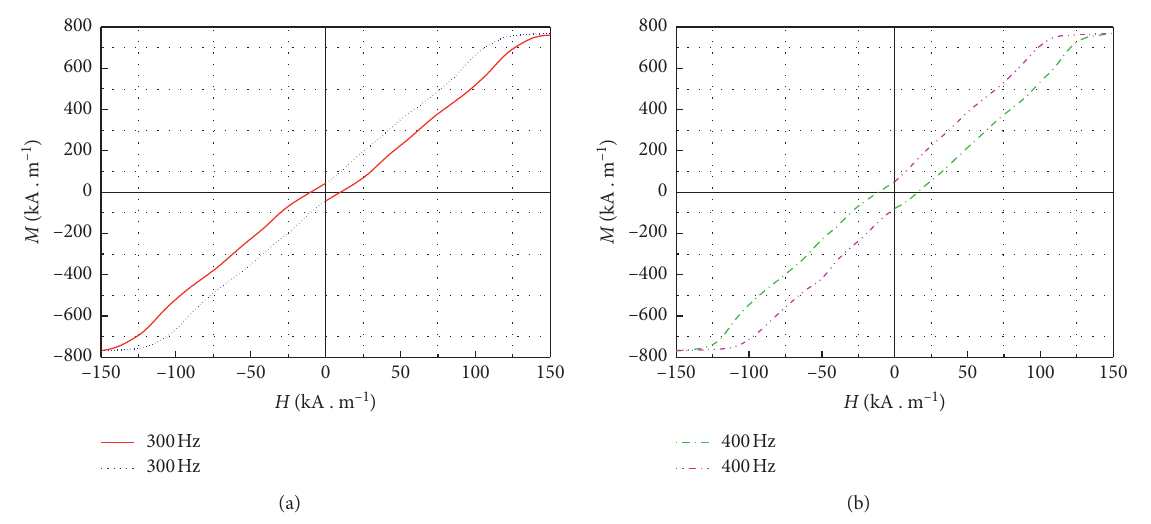
Figure 7: Magnetic field intensity-magnetization curve.(a) 300Hz. (b)